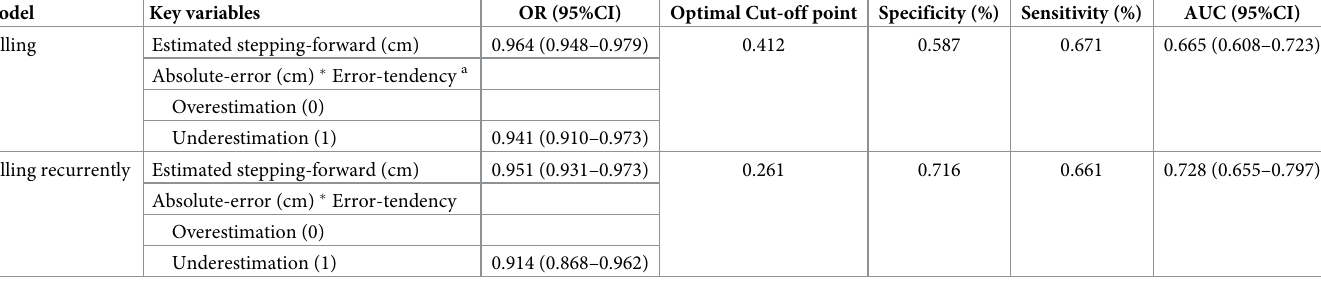
Table 2. The two most parsimonious and fit build binary logistic regression models and respective key SF-APT variables explaining falling and falling recurrently (falling vs. non-falling model: N = 347; falling recurrently vs. non-falling model: N = 263).